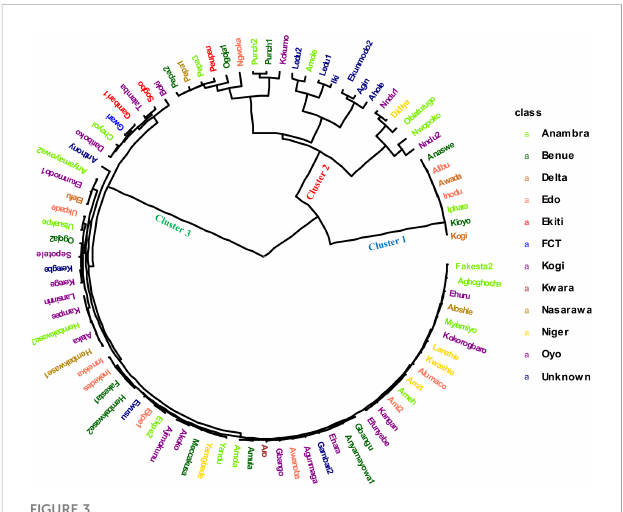
FIGURE 3 Hierarchical clustering analysis based on 4,432 DArT-SNP markers showing the genetic relationship among 86 Nigerian white Guinea yam landraces. The landraces collected from different locations of Nigeria are presented in different color.